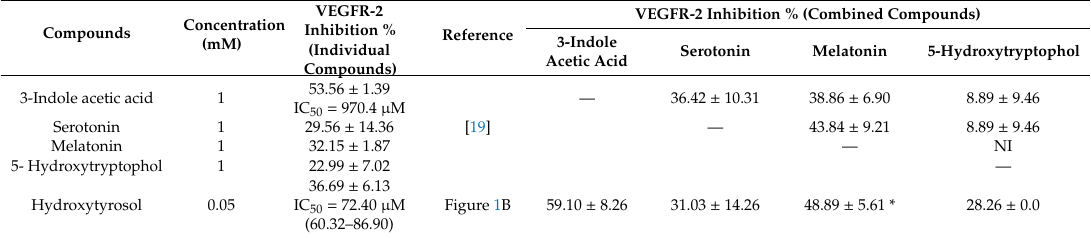
Table 1. Vascular endothelial growth factor (VEGF)-induced VEGFR-2 inhibition percentage (%) of individual and combined compounds.